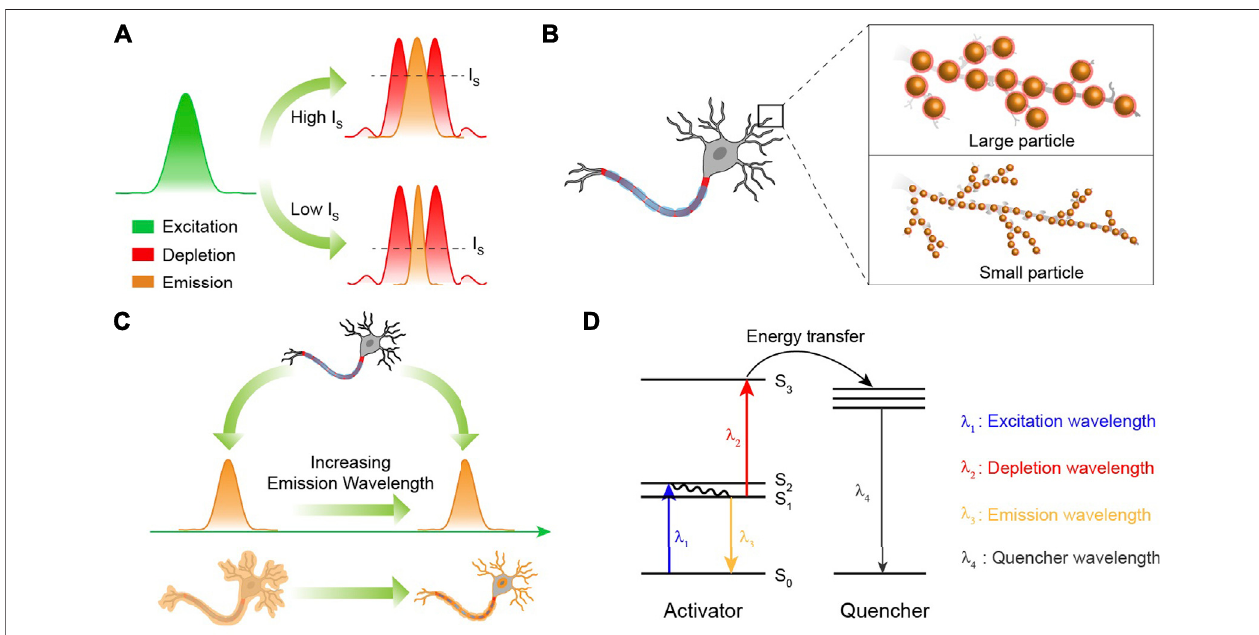
FIGURE 4 | (A) The spatial region that fl uoresces can be narrowed by reducing the saturation intensity (I S ). Green, red, and yellow curves represent the areas of excitation,depletion,andemission,respectively. (B) Thesmallernanoparticlesthatstillpossessastrong fl uorescenceintensitywillensureahigherspatialresolutionthan thelargerones. (C) InSTEDnanoscopy,the fl uorescenceprobeswithalongeremission wavelengthwillbefavorablefor invivo super-resolutionimagingduetotheirlow photon scattering. (D) The excited state absorption mechanism for lanthanide ions in STED nanoscopy. λ 1 is the wavelength of the excitation laser. λ 2 is the wavelength of the depletion laser. λ 3 is the emission wavelength. λ 4 is the emission wavelength of the chosen quenchers. In the design, depletion laser, energy transfer from